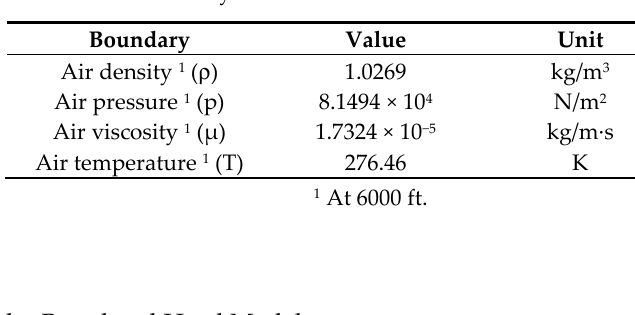
Table 3. Boundary conditions and values for 3D